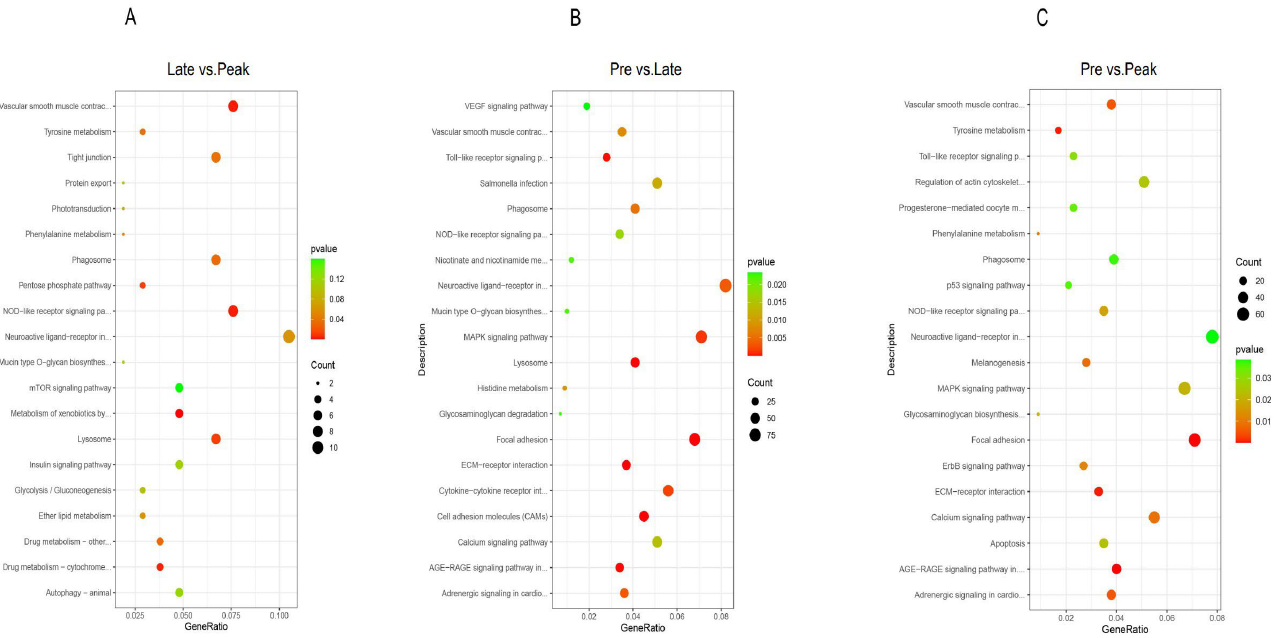
Figure 4. The 20 most significant KEGG pathways in the three comparison groups. ( A ): the late vs. peak stage, ( B ): the pre vs. late stage, and ( C ): the pre vs. peak stage.